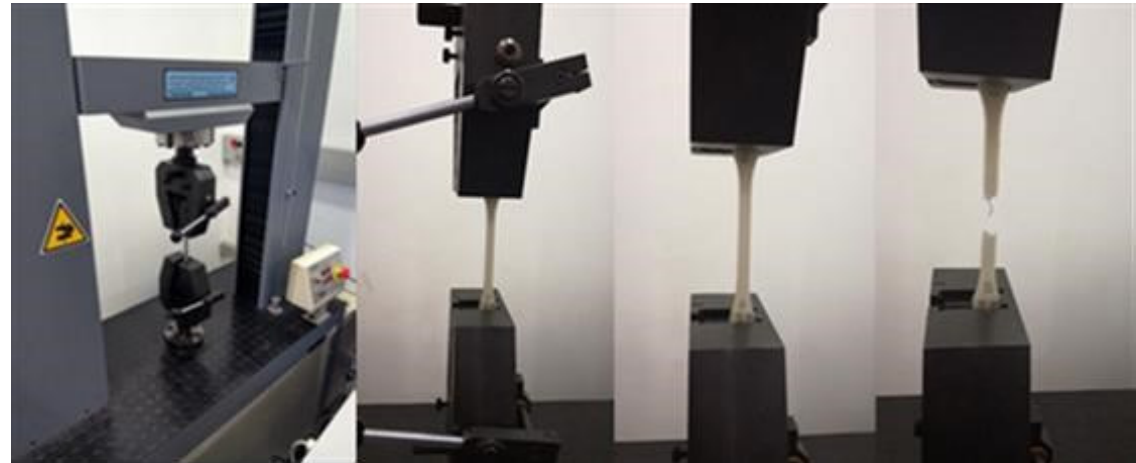
Figure 7. Servosis ME-405 machine and tensile test performance.